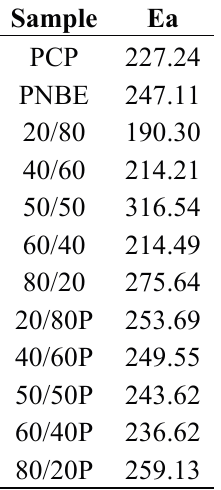
Table 6. Activation energies for the homopolymers and the statistical copolymers from the Kissinger